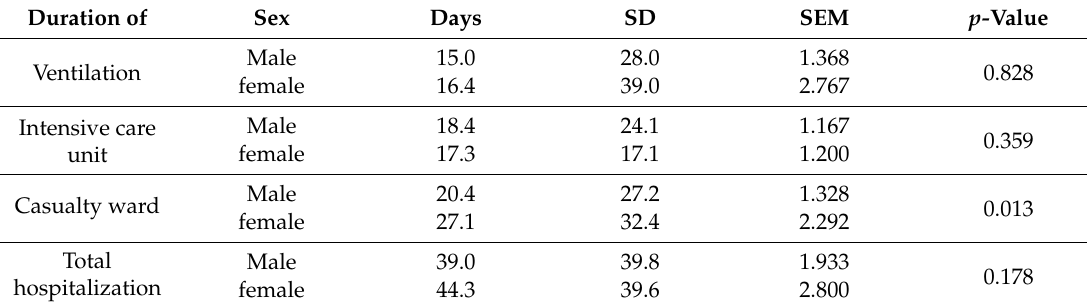
Table 3. Intensive Care